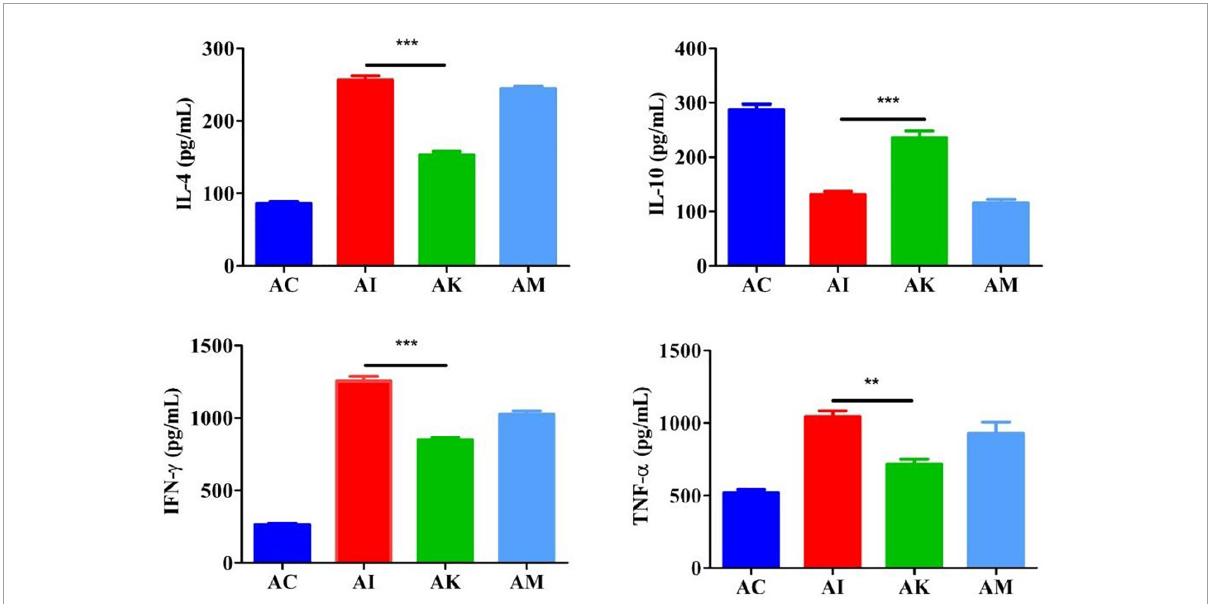
FIGURE3 Serum levels of IL-4, IL-10, IFN- γ , and TNF- α in mice with acute T. gondii infection at 6 dpi. AC: no T. gondii + PBS; AI: 50 T. gondii cysts + PBS; AK: 50 T. gondii cysts + koumiss; AM: 50 T. gondii cysts + mare’s milk. All data are expressed as mean ± SD. ** P < 0.01; *** P <